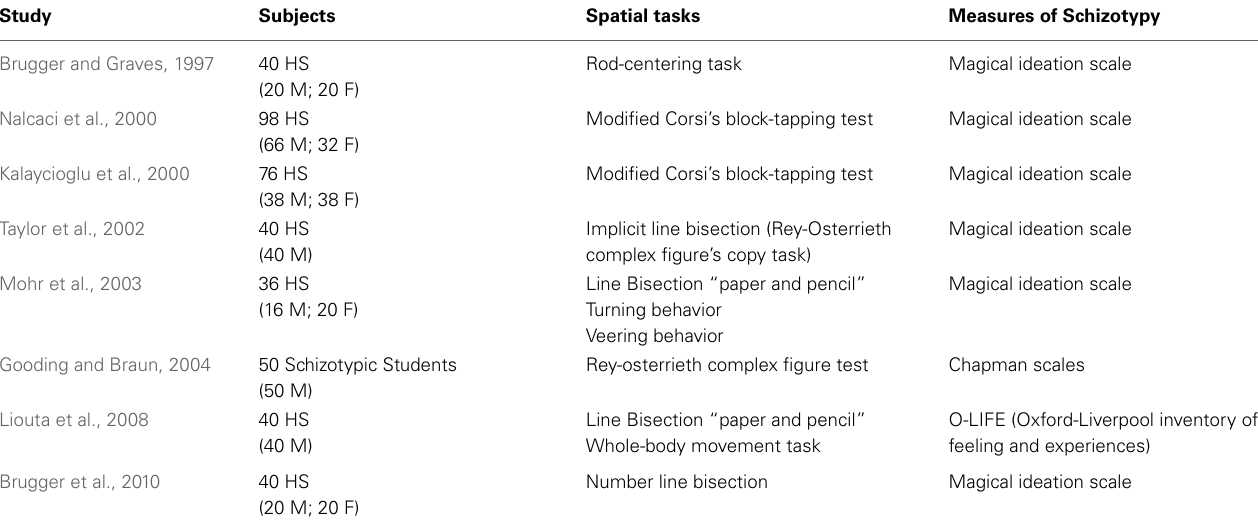
Table 1 | Summary of the studies that investigated schizotypy and spatial